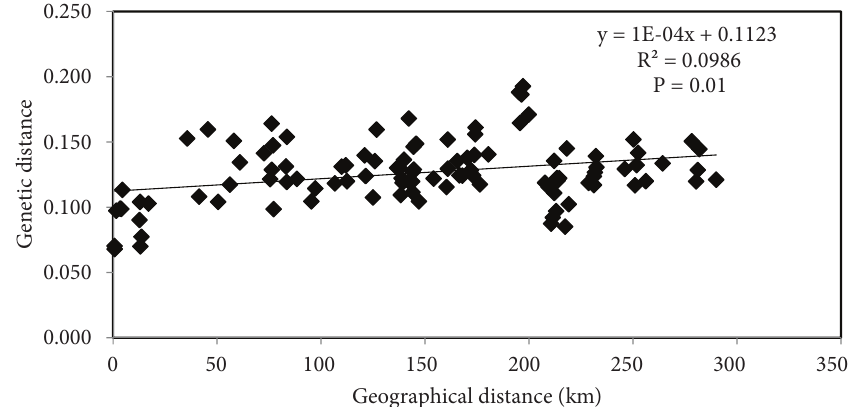
y = 1E-04x + 0.1123 R² = 0.0986 P = 0.01